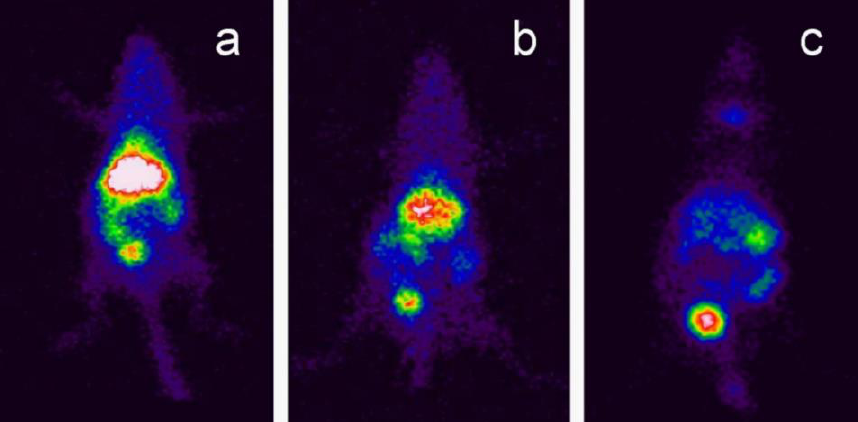
Figure 8. Scintigraphic image of radiographic GC-BNNTs biodistribution in mice; ( a – c ) show the images after injecting at time intervals of 30 min, 1, and 4 h, respectively. Reproduced with permission from Ref [71]. Copyrights 2012, Elsevier.